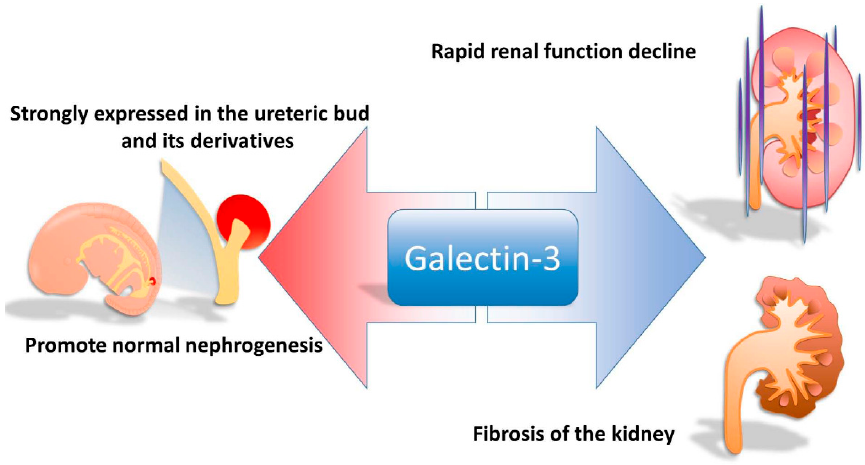
Figure 2. The influence of galectin-3 in the kidneys.